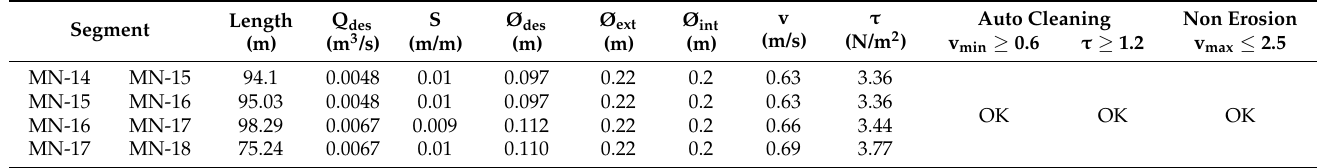
Table 12. Design of the sewerage network in expansion zones 2 and 3.